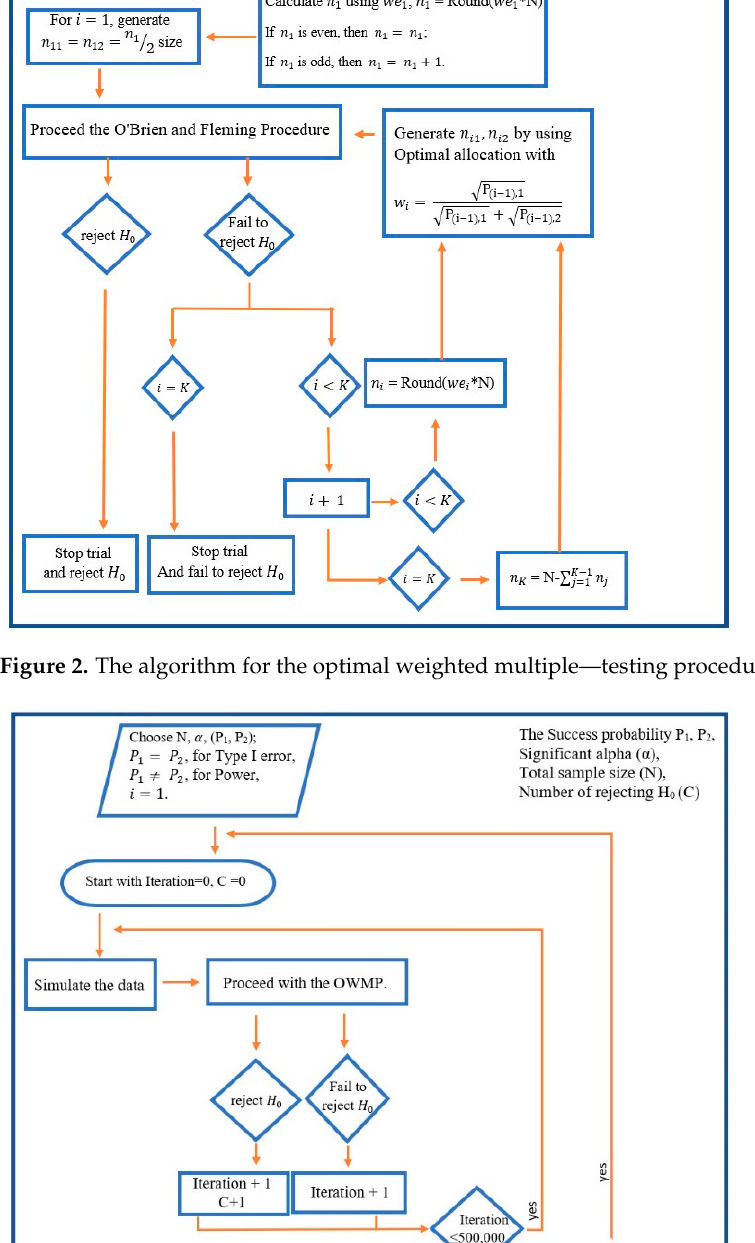
Figure 3. The algorithm to calculate the values of the Type I error and power using Monte Carlo simulations with the OWMP.